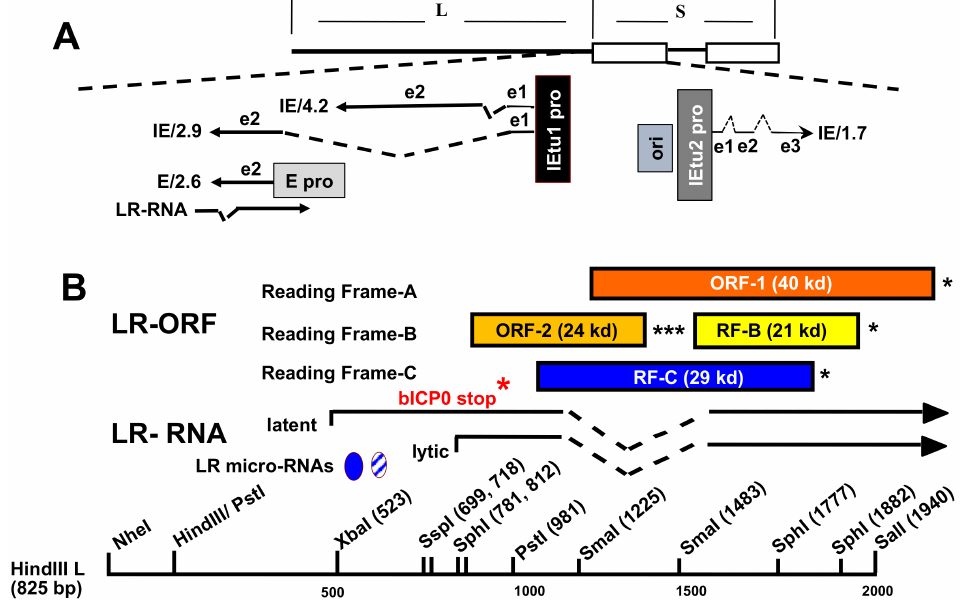
Figure 1. Schematic of BoHV-1 genes encompassing the LR gene. ( A ) The BoHV-1 genome contains a unique long (L), a unique short (S), and two repeats denoted by white rectangles. Positions of IE transcripts and LR transcript (LR-RNA) [45,46,50] are denoted. IE/4.2 is the IE transcript that encodes bICP4. IE/2.9 is the IE transcript that encodes bICP0. The IEtu1 promoter activates the expression of IE/4.2 and IE/2.9 and is denoted by a black rectangle (IEtu1 pro). E/2.6 is the early transcript that encodes bICP0, and a separate early promoter regulates the expression of the E/2.6 transcript (E pro). Exon 2 (e2) of bICP0 contains all the protein-coding sequences. The origin of replication (ORI) separates IEtu1 from IEtu2. The IEtu2 promoter (IEtu2 pro) drives the expression of the bICP22 protein. Solid lines in the transcript denote exons (e1, e2, e3) and dashed lines introns. ( B ) Partial restriction map of LR gene. The LR gene contains two open reading frames (ORF-1 and ORF-2) [51–53]. Reading frame B (RF-B) and reading frame C (RF-C) do not contain an initiating methionine. Asterisks denote the positions of in-frame stop codons. Start sties for lytic and latent LR-RNA are denoted. The position of the bICP0 termination codon (single red *) and LR-micro-RNAs are also denoted. The *** denote the position of the three in frame stop codons for